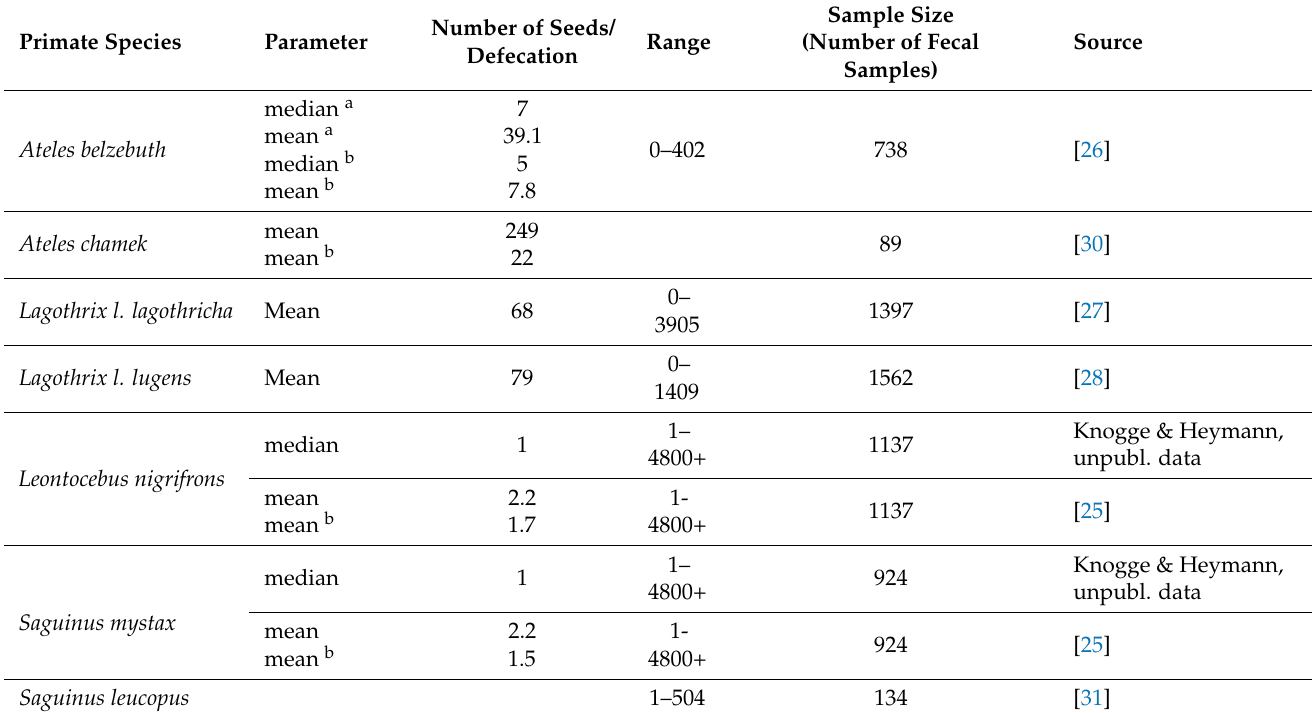
Table 2. Number of seeds per